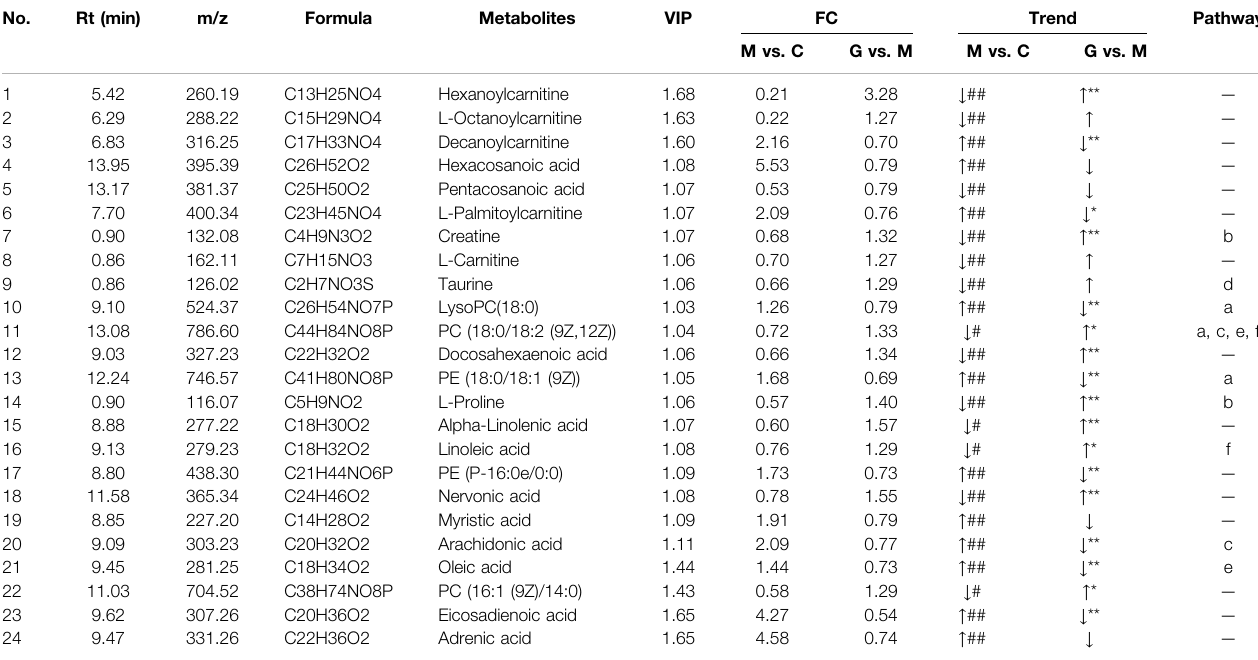
TABLE 4 | Summary of the differential metabolites identi fi ed in the serum of three Groups. No. Rt